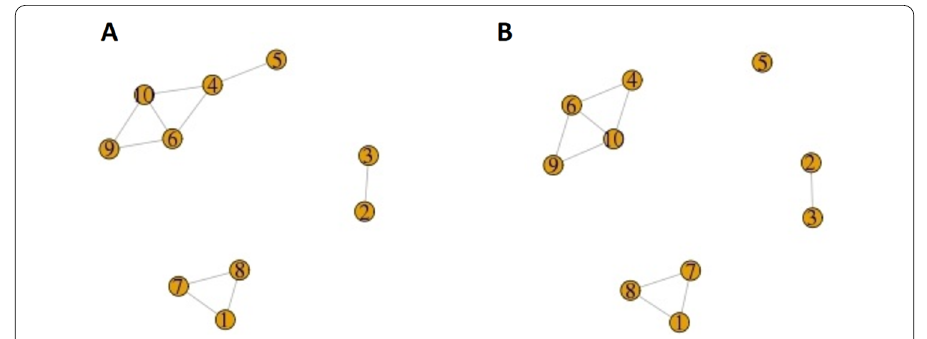
Figure 8 Example of the clustering algorithm. ( A ) Initial situation. Each node is an ad; nodes are linked if they are duplicates. The 1–7–8 and 2–3 subgraphs are fully connected; the 4–5–6–9–10 subgraph is not. ( B ) Final situation. We split the cluster 4–5–6–9–10 by removing the edge with minimal duplicate probability, in this case 4–5. The cluster 4–6–9–10 is still not fully connected, but sufficiently connected. As a condition for N ( N –1) connectivity, we choose M ≥ 5 , where M is the number of edges and N the number of nodes in 6 2